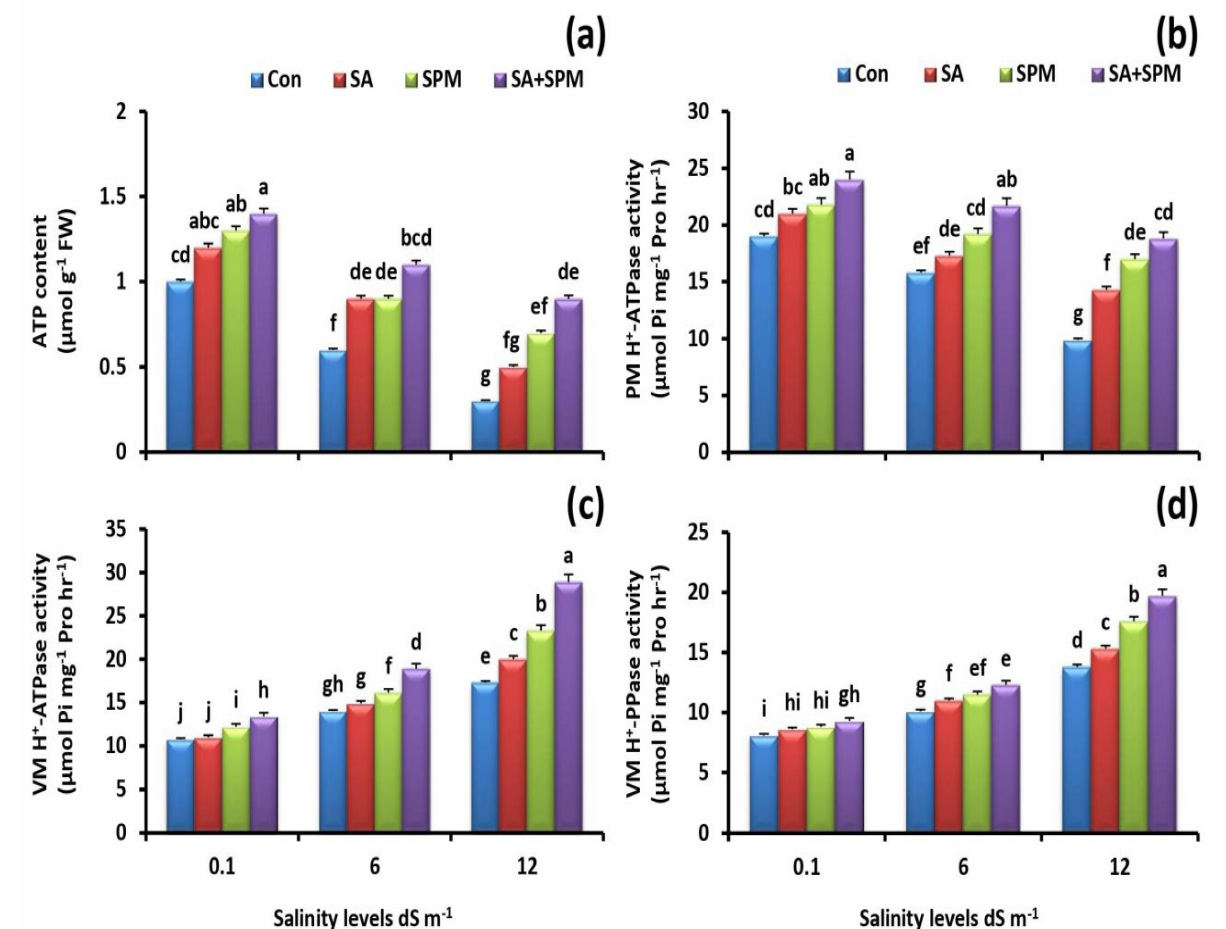
Figure 4. Effect of salicylic acid (SA) and/or spermine (SPM) foliage applications on the ( a ) ATP content, ( b ) plasma membrane (PM) H + -ATPase activity, ( c ) vacuole membrane (VM) H + -ATPase activity, and ( d ) vacuole membrane (VM) H + -PPase activity in roots of wheat plants exposed to non-saline and saline (6.0 and 12.0 dS m − 1 ) conditions. The results showed the mean ± SE of four replicates. Different letters indicate significant differences at ( p < 0.05) level according to Duncan’s